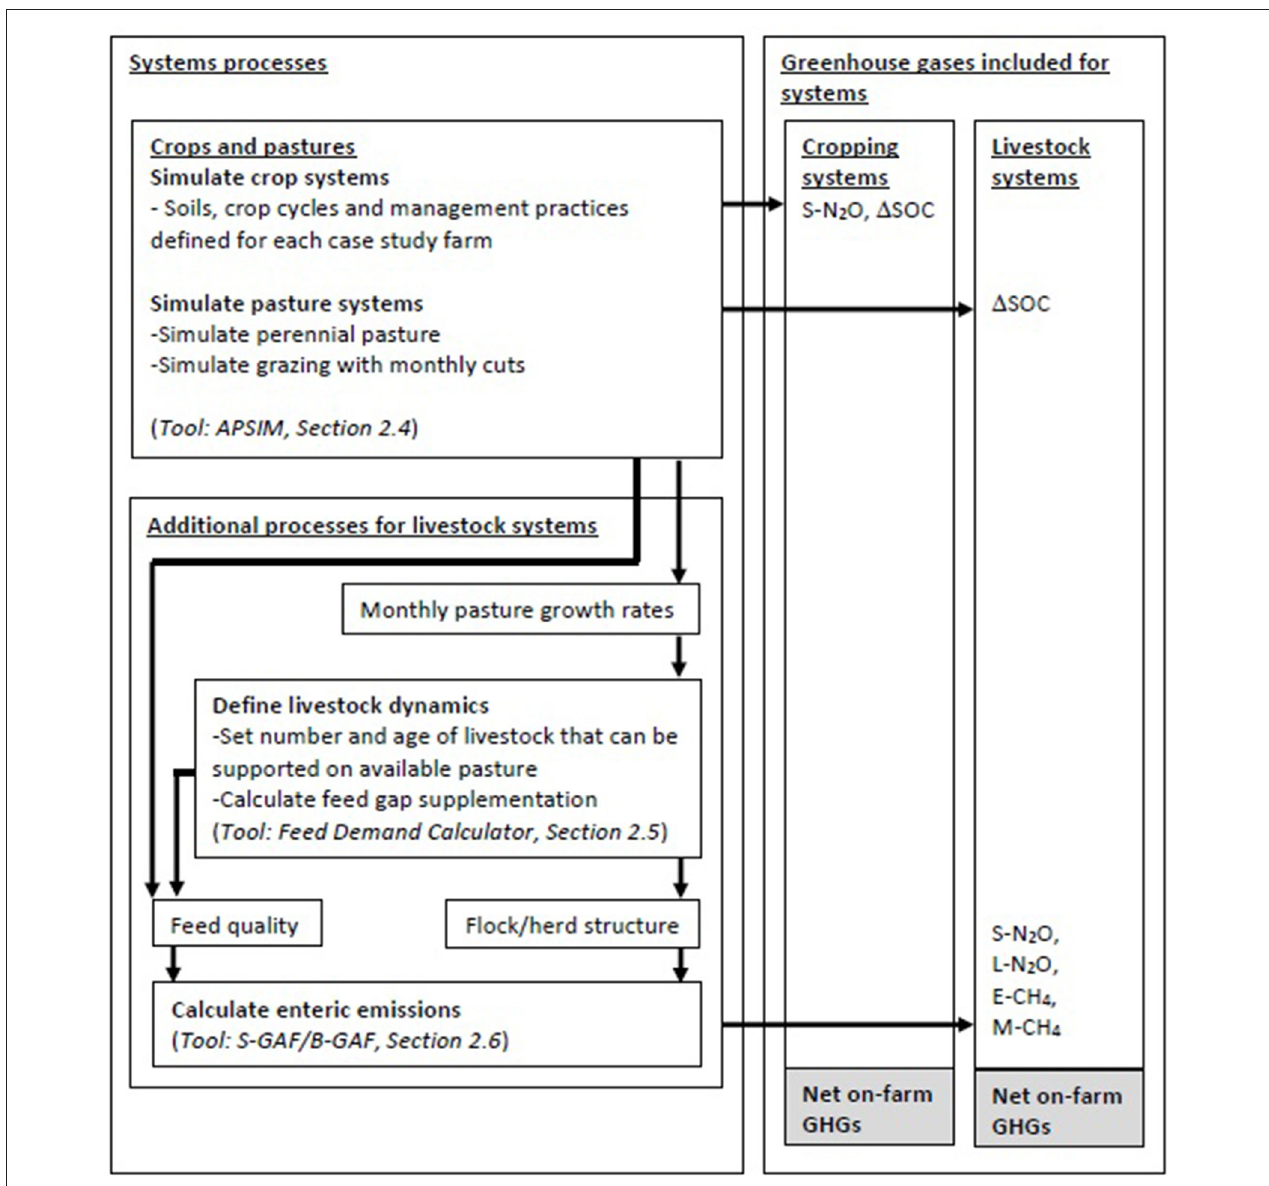
FIGURE 2 | Overview of the approach used to integrate tools for simulating crops, pasture and livestock production and on-farm greenhouse gas (GHG) emissions for the case study farms. Greenhouse gas emissions included (1) N 2 O from the soil (S-N 2 O) and from urine and manure wastes from livestock (L-N 2 O), (2) CH 4 from enteric sources (E-CH 4 ) and from manure (M-CH 4 ), and (3) the net change in atmospheric concentrations of CO 2 derived from sequestration or decomposition of soil organic carbon ( 1